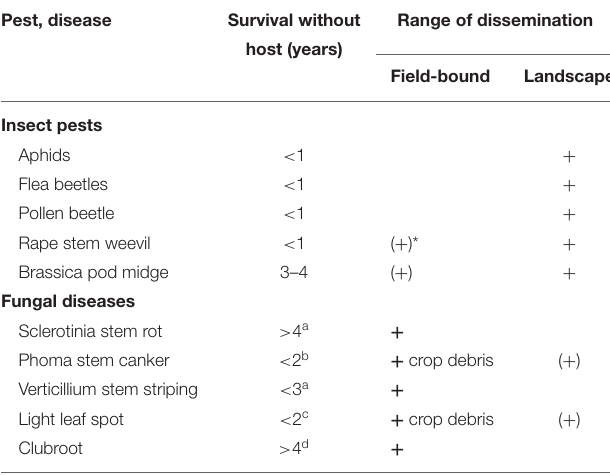
TABLE 7 | Survival and range of dispersal of the top 5 important pests and diseases of oilseed rape in Europe. Pest, disease Survival without Range of dissemination host (years) Field-bound